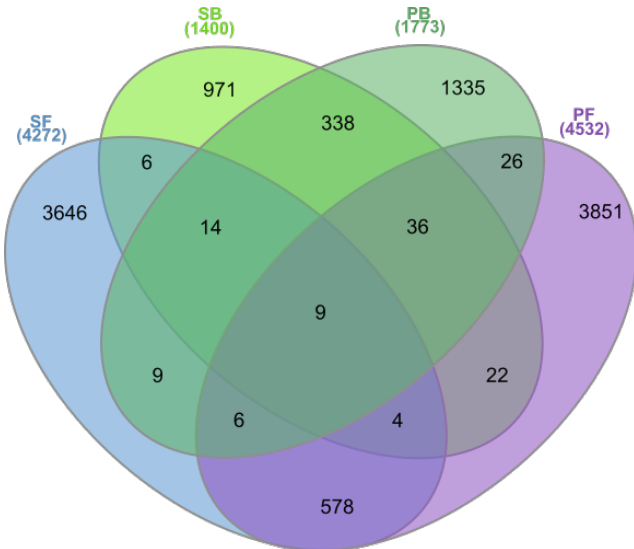
Figure 5. The Venn diagram showing the number of Operational Taxonomic Units (OTUs) shared by different peatland sites: Shichengskoe bog (SB), Shichengskoe fen (SF), Piyavochnoe bog (PB), and Piyavochnoe fen (PF).